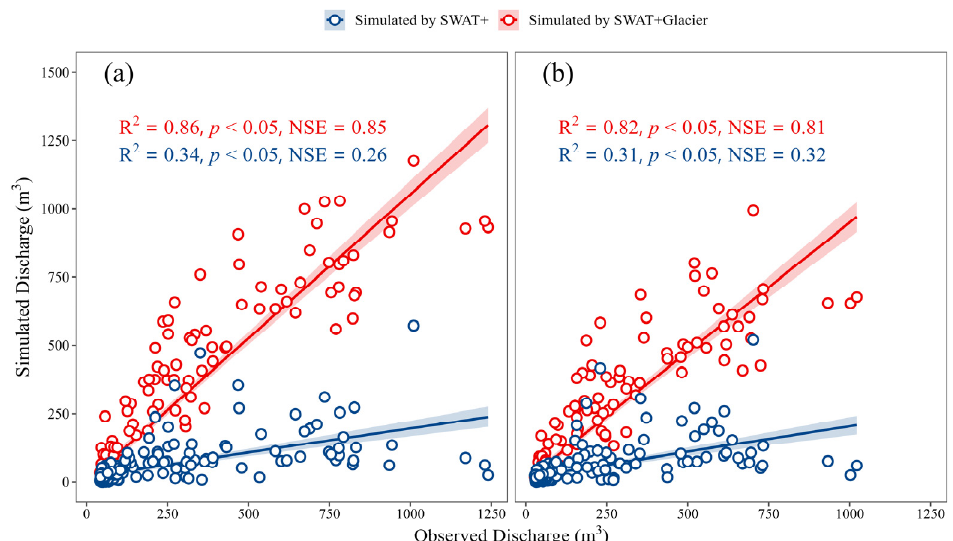
Figure 6. Comparison of discharge simulated by SWAT+ and SWAT+Glacier; ( a ) Kaqun station, ( b ) Kuluklangan station.